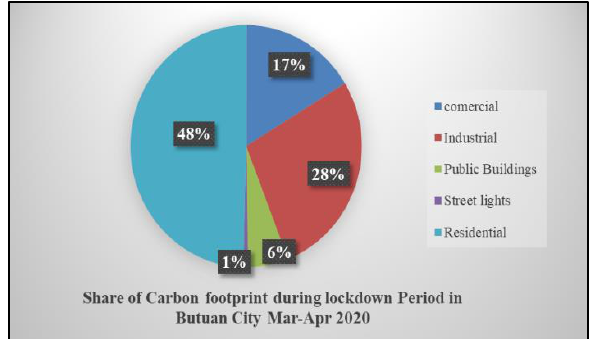
Figure 4. Disaggregation of the total carbon footprint by every sector relative to the lockdown